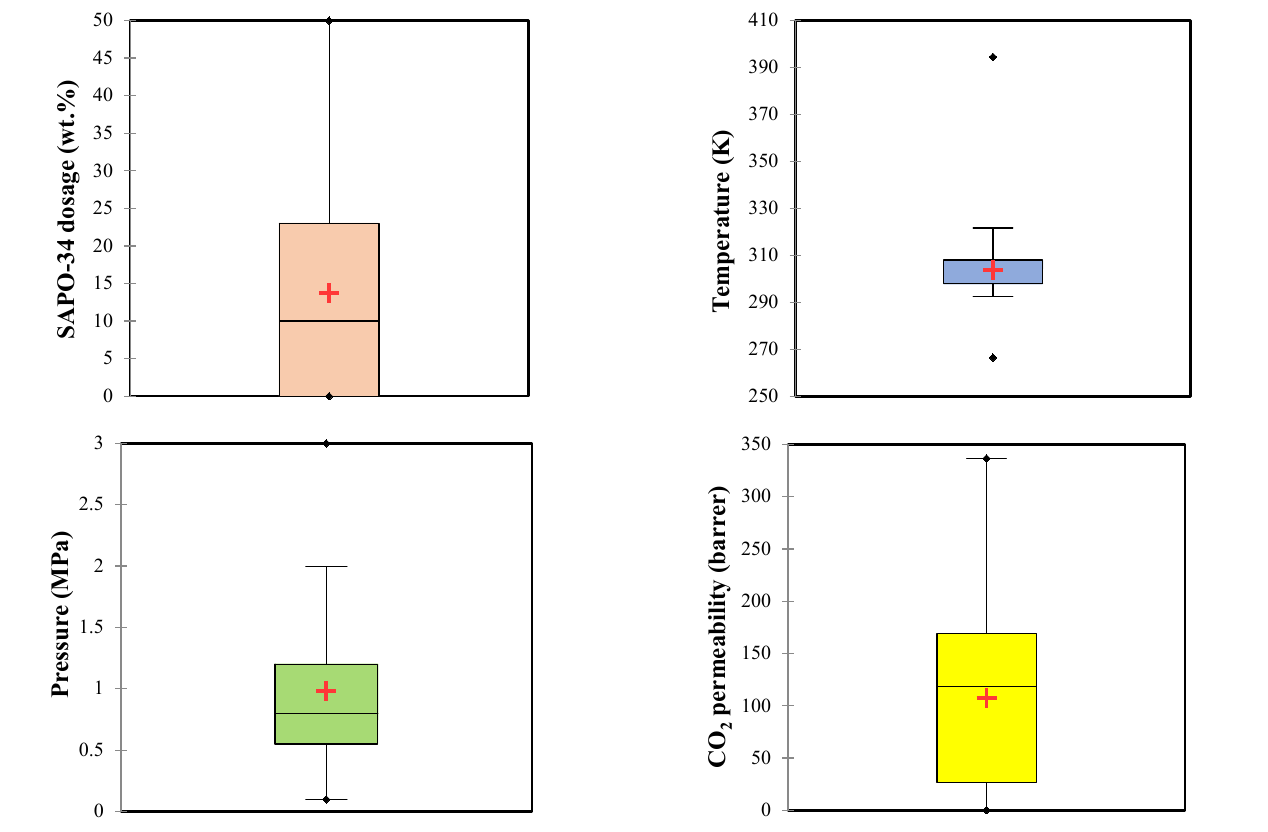
Figure 1. Box plot presentation of statistical information of the collected experimental databank.